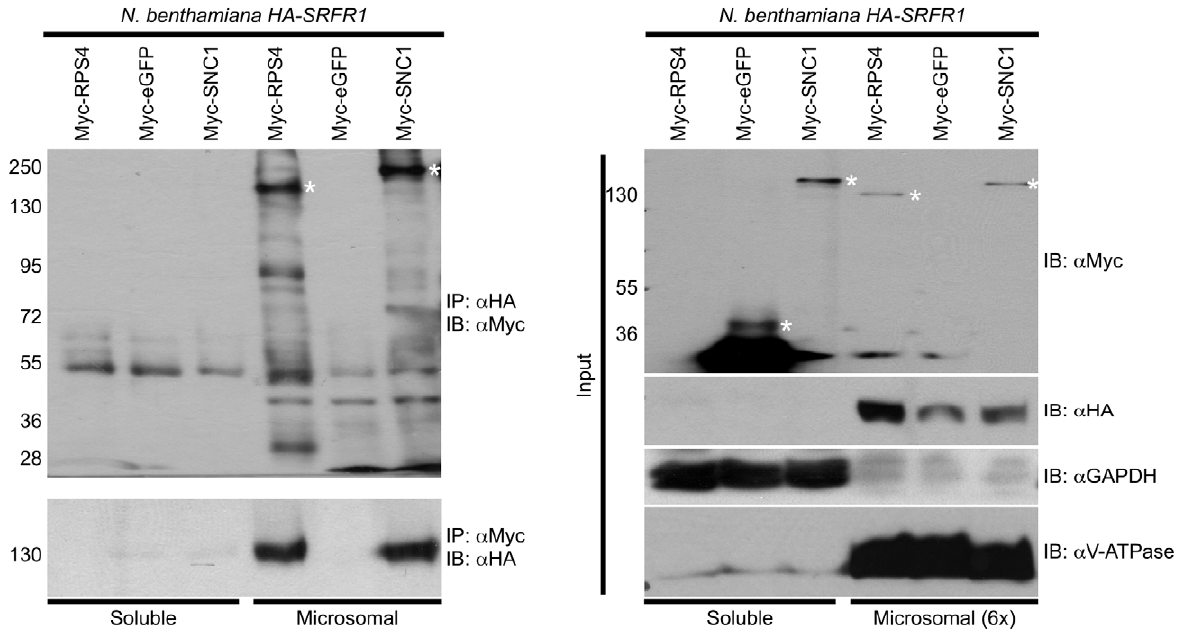
Figure 9. SRFR1 interacts with RPS4 and SNC1 in the microsomal fraction. Myc-RPS4, Myc-eGFP or Myc-SNC1 were transiently expressed via Agrobacterium -mediated transient expression in N. benthamiana transgenic lines 6-4 and/or 7-1 expressing HA-SRFR1. Immunoprecipitation (IP) analysis was performed on soluble and microsomal fractions with the indicated antibodies. The immunoprecipitates were immunoblotted (IB) with the indicated antibodies (left panel). The right panel shows the corresponding protein expression levels in the input fractions for immunoprecipitation analyses. In the right panel, the microsomal fraction is 6-fold enriched compared to the soluble fraction. Molecular weight of protein standards (in kD) are shown on the left of the panels. Asterisks denote the expected sizes of the Myc-tagged proteins. The degree of soluble and microsomal fraction enrichment are shown by IB analyses with anti-GAPDH and anti-V-ATPase antibodies. The assay was repeated three times with similar